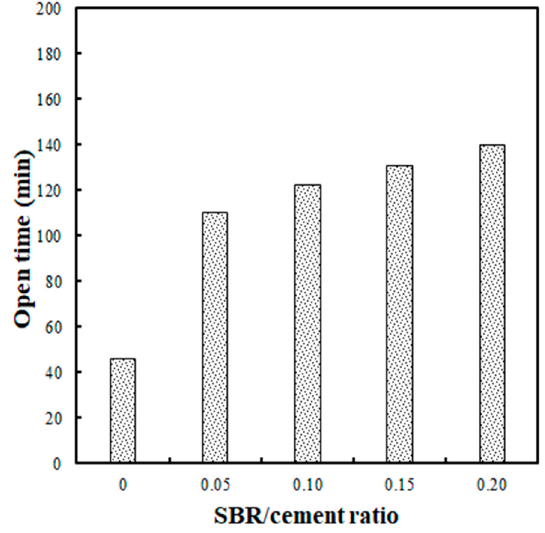
Figure 11. Comparison of open times for different SBR/cement ratios.